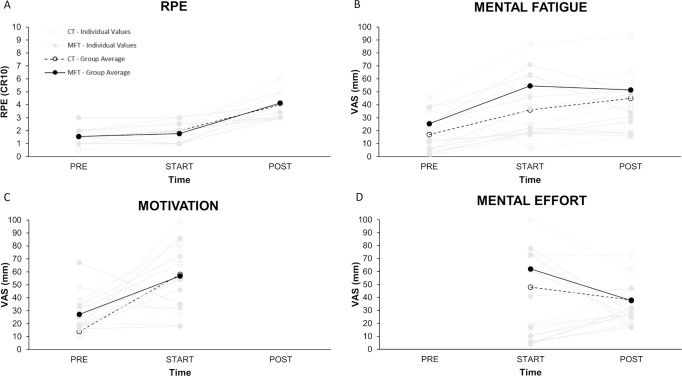
Perceptual responses of RPE (panel A), mental fatigue (panel B), motivation (panel C) and mental effort (panel D) throughout the experimental period (PRE, START, and POST). RPE = rate of perceived exertion.